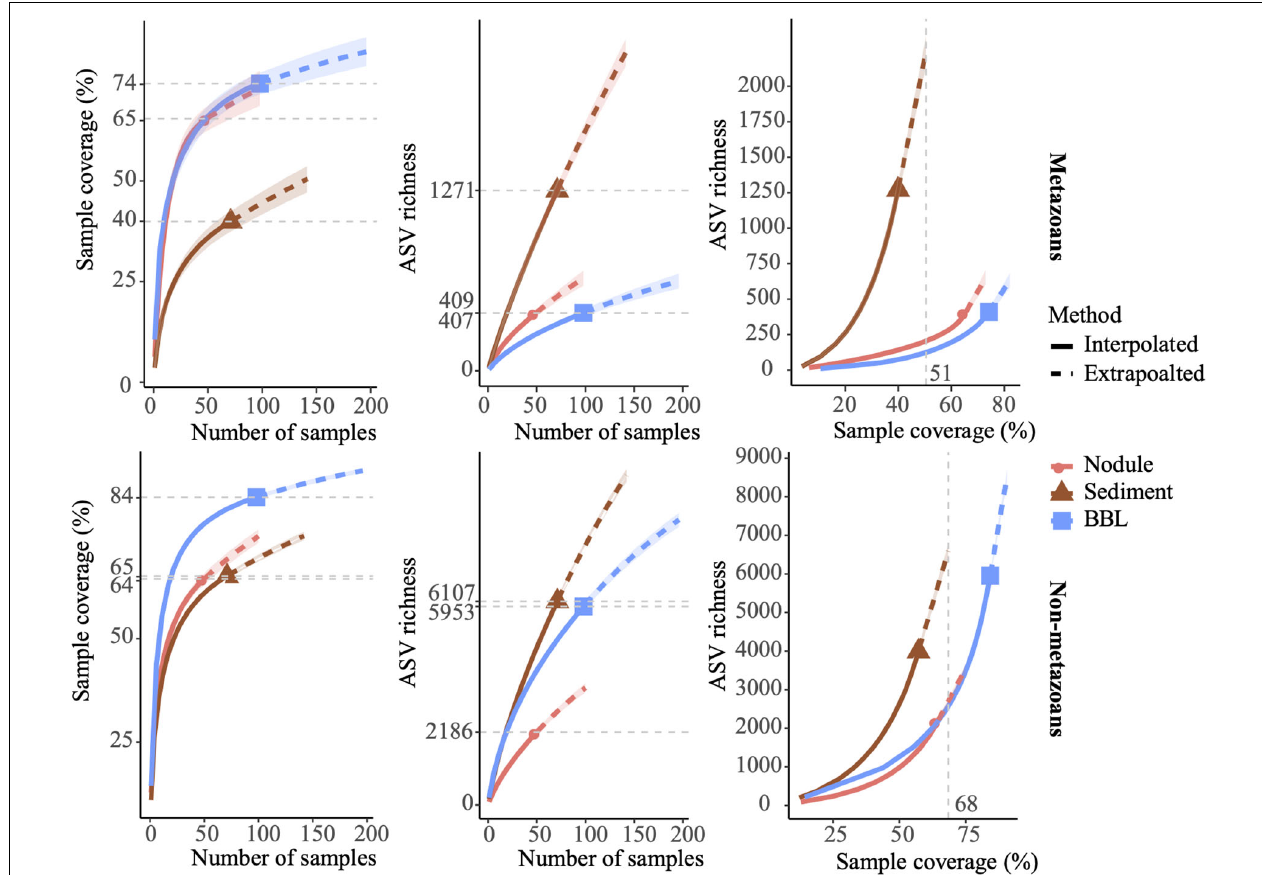
FIGURE 2 | Amplicon sequence variant (ASV) sampling coverage and richness for each sample type (nodule, sediment, and seawater). ASV richness was estimated using Chao2 (Chao and Jost, 2012). Shaded, colored areas indicate the 95% confidence intervals obtained from a bootstrap method based on 200 replicates. Horizontal dotted gray lines (left and center) indicate maximum interpolation values for each sample type. Vertical dotted gray lines (right) indicate the value at base coverage, defined as the highest coverage value between minimum extrapolated values and maximum interpolated